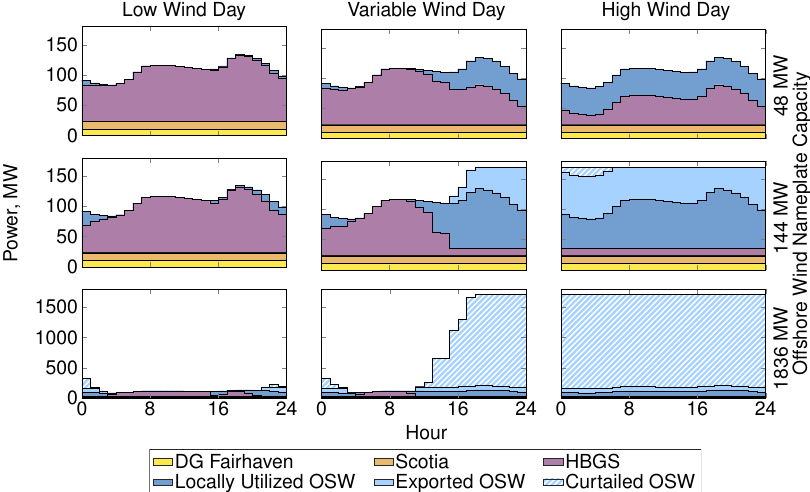
Figure 16. Monthly electricity generation by source to meet Humboldt County’s projected 2030 load profile with addition of 1836-MW o ff shore wind